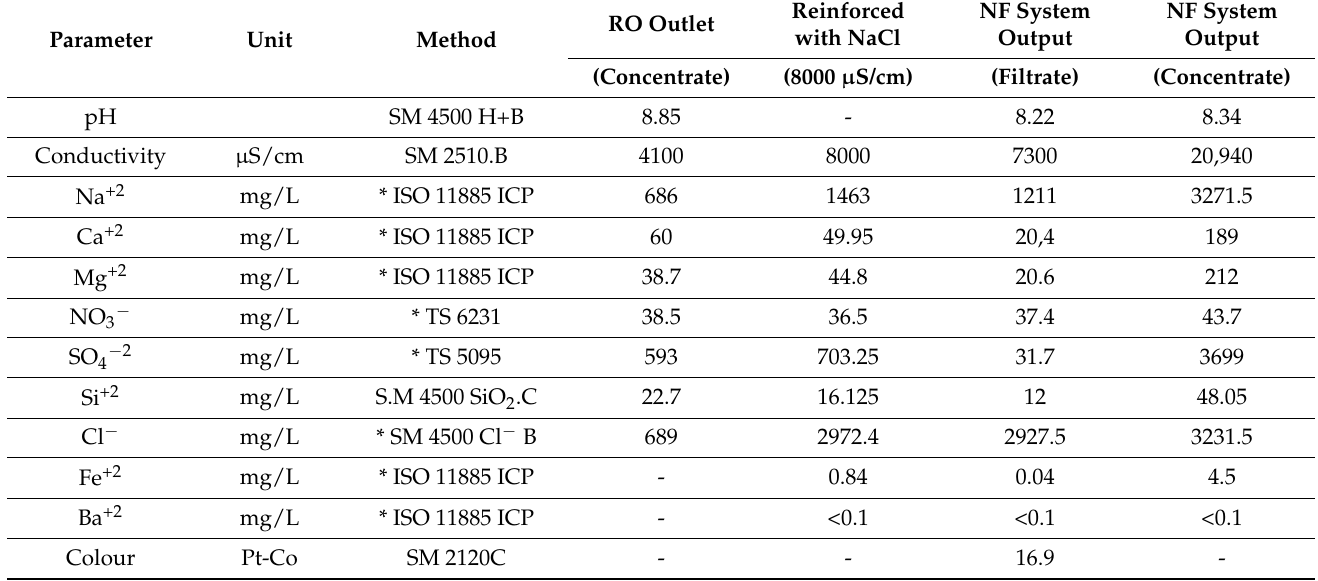
Table 3. Wastewater analyses and methods made within the scope of the